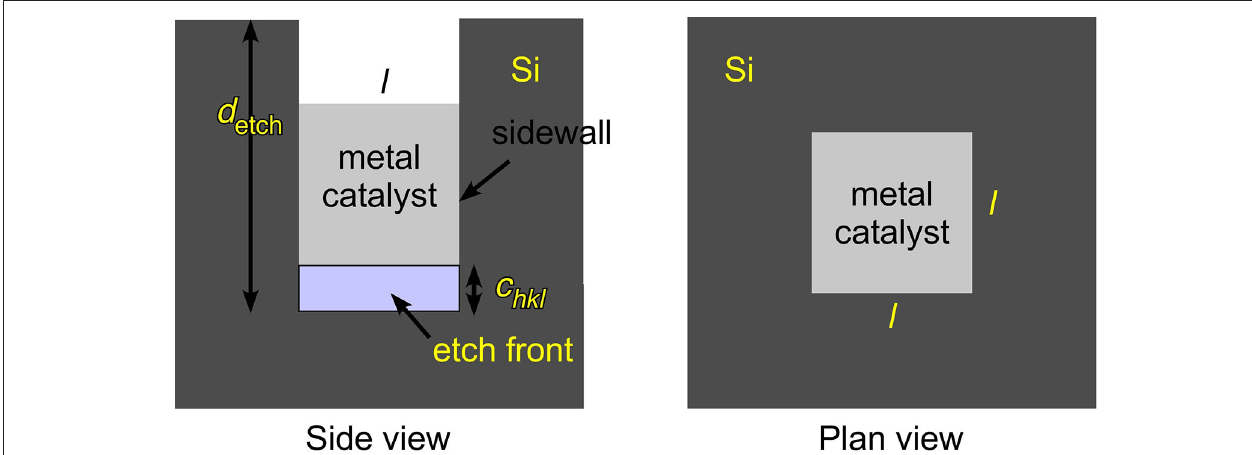
FIGURE 7 | Metal assisted catalyzed etching (MACE) is represented schematically for a cubic metal catalyst of side length l etching with a planar etch front that is perpendicular to the sidewalls. The sidewalls need not be perpendicular to the macroscopic normal to the wafer/particle that is being etched. The total etch depth d etch is obtained by stepwise removal of one surface unit cell after another with a step depth c hkl that depends on the surface crystallography of the plane that contains the etch